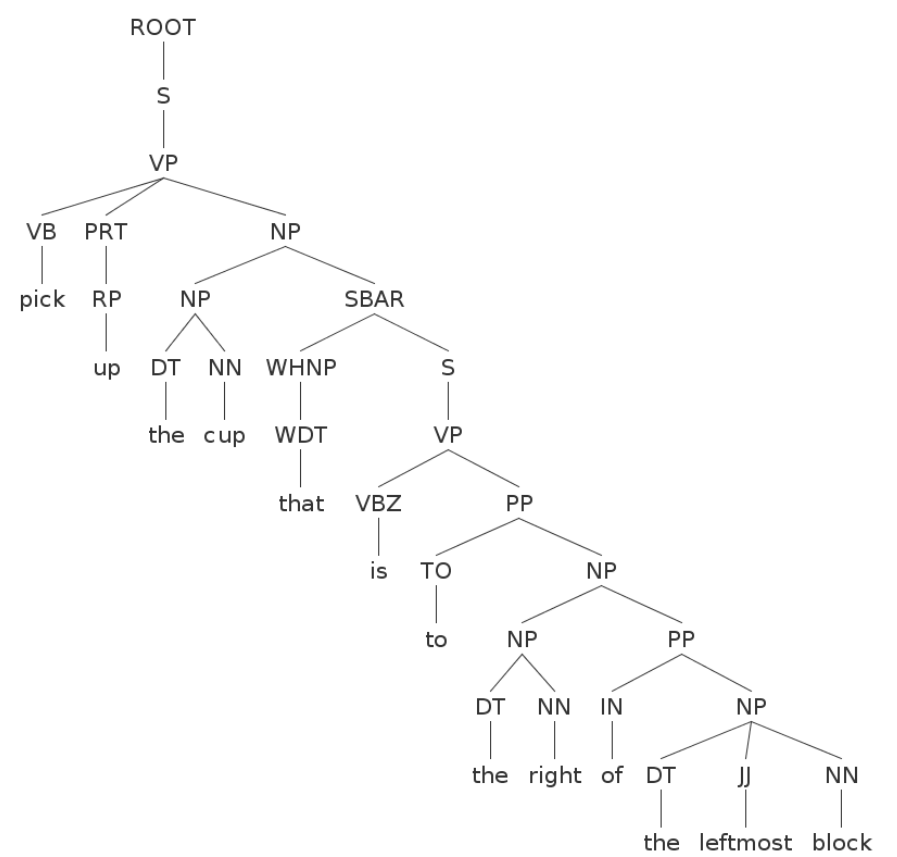
Figure 3. The parsed syntactic structure for the NL instruction “pick up the cup that is to the right of the leftmost block”. Please find the tags shown in the figure in the Penn Treebank [37] syntactic and part-of-speech tag-sets.